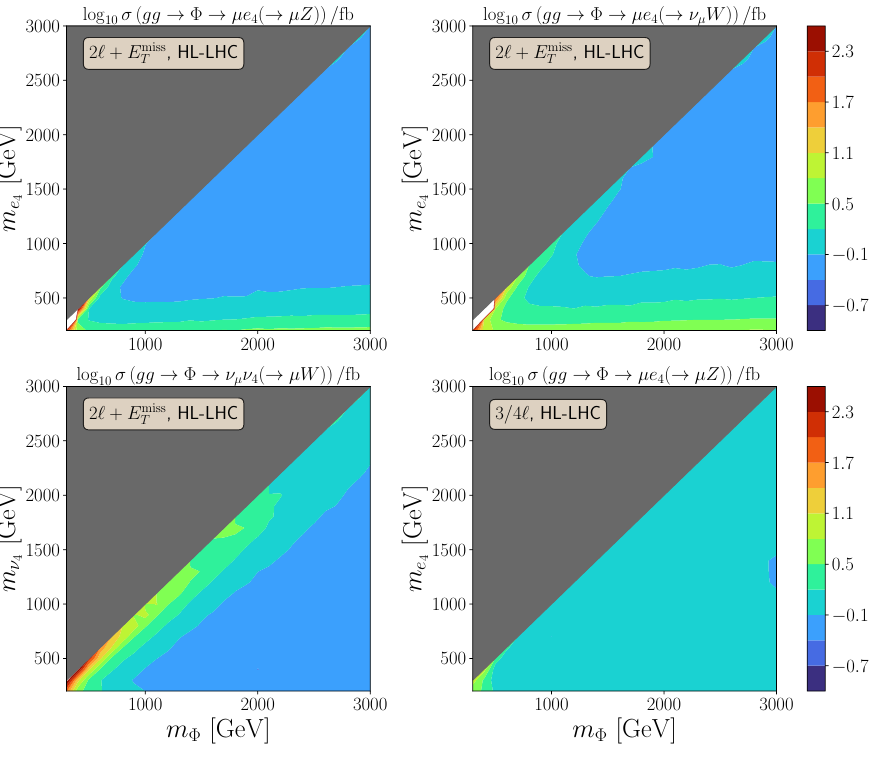
Figure 6 . Projected upper bounds on σ ( bb → Φ → ‘‘ 4 ( → ‘ 0 V )) at the